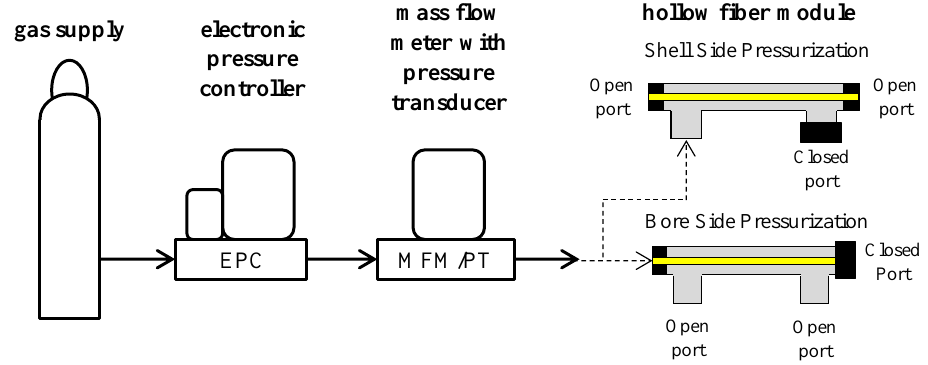
Figure 6. Schematic of bubble point measurement apparatus with bore and shell side pressurization configurations.